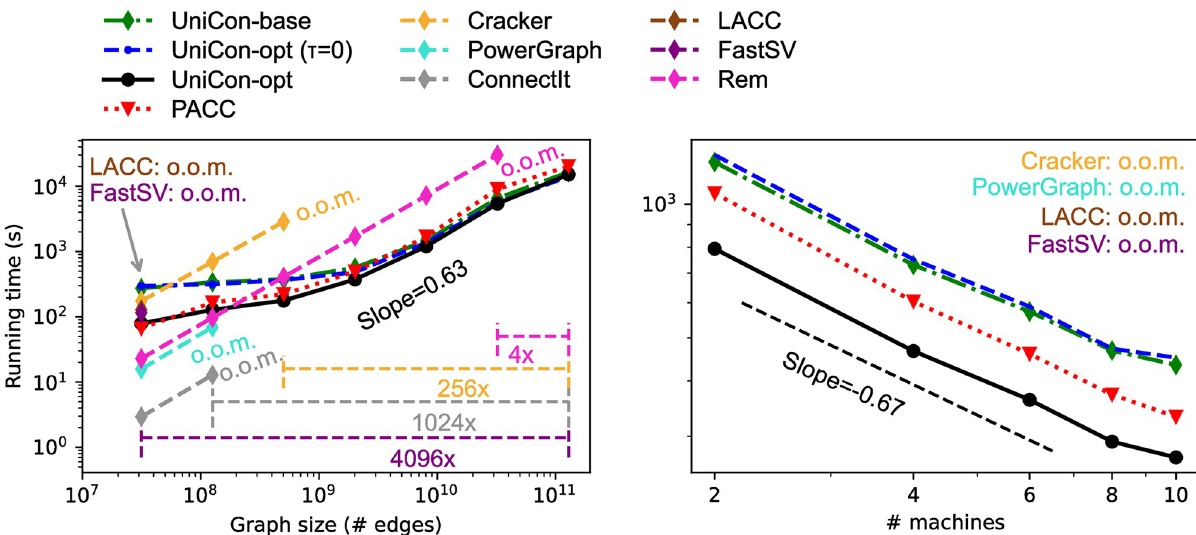
Fig 14. Data and machine scalability. (left) UniCon handles up to 4096 × larger graphs than competitors. (right) UniCon-opt shows the best performance regardless of the number of machines.